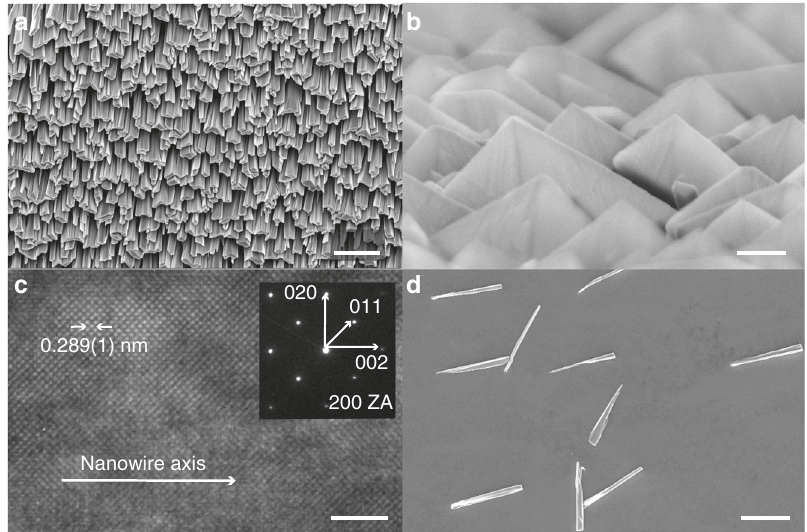
Fig. 2 Growth of single-crystal FeCo nanowires. a Scanning electron micrograph (top-down view) of an as-fabricated sample. Scale bar is 2 µ m. b Scanning electron micrograph of the same sample as seen from the FeCo source. Scale bar is 200 nm. c High-resolution transmission electron micrograph (HRTEM) of a FeCo nanowire viewed down a 〈 100 〉 zone axis. Inset shows Fourier transform of data collected from a larger region of the same nanowire. Data are consistent with a body-centered cubic (bcc) structured crystal with a 〈 100 〉 direction coinciding with the nanowire growth axis. Scale bar is 2 nm. d Isolated nanowires after transfer to a secondary substrate. Scale bar is 2 µ